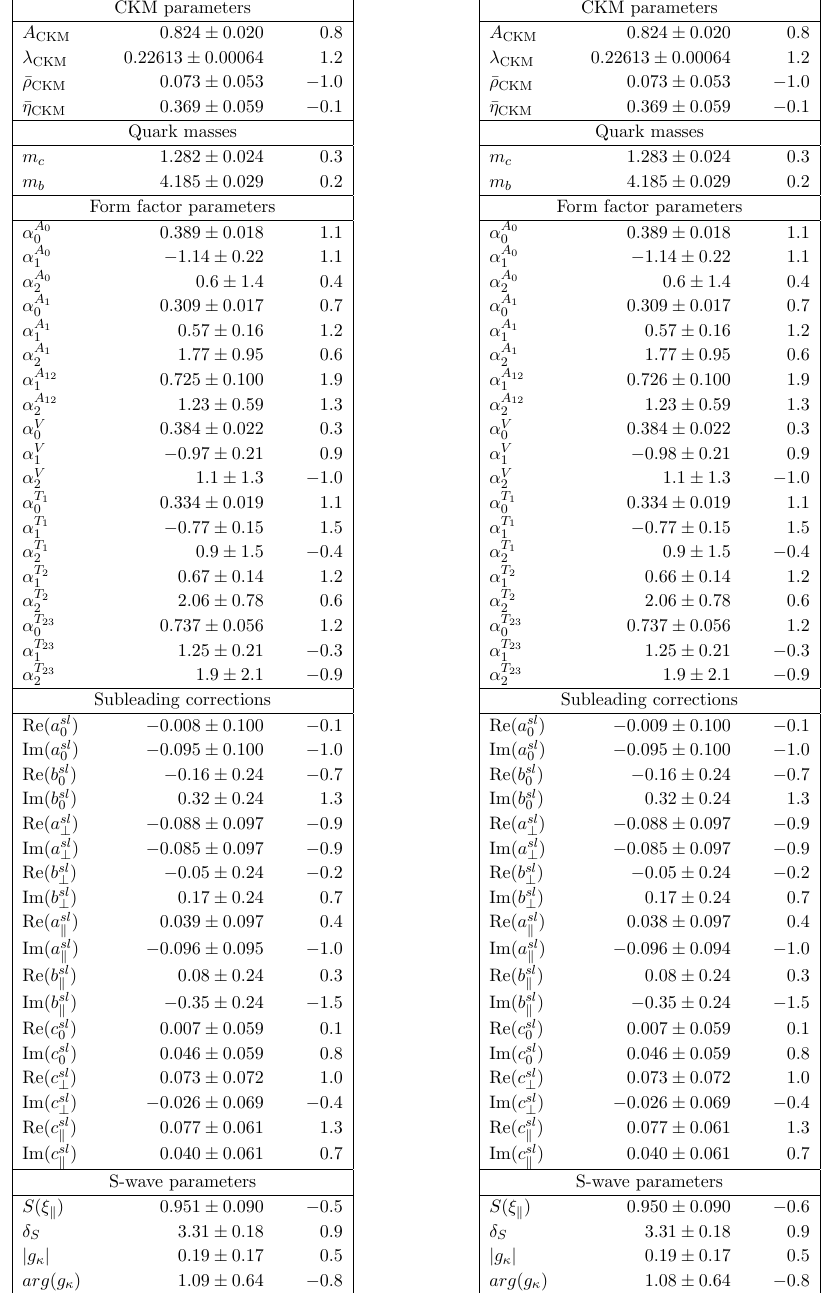
Table 4. Results from the direct (cid:12)t method for a single pseudoexperiment varying (left) the Wilson coe(cid:14)cients Re( C 7 ) and Re( C 9 ) and (right) the Wilson coe(cid:14)cients Re( C 9 ) and Re( C 10 ). Background parameters are omitted for brevity.